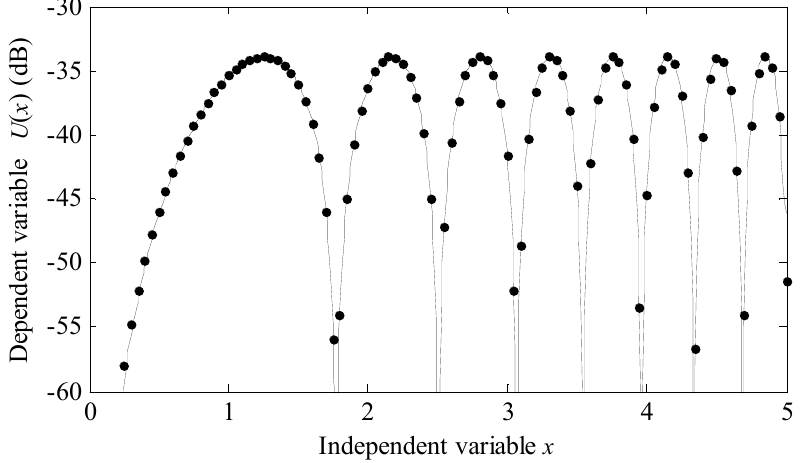
Figure 12. Independent variable versus dependent variable for the exponential function coefficient second order differential equation. The solid line is the series solution and the circular markers are the closed form solution.